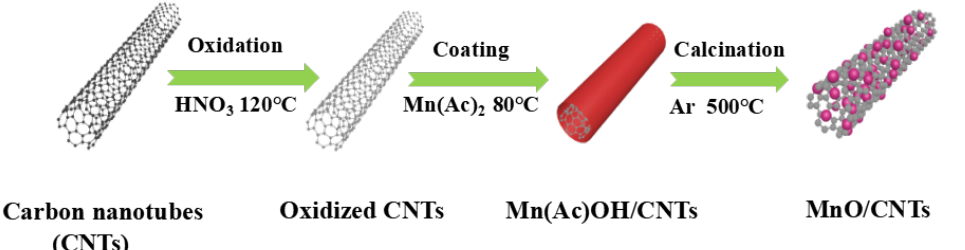
Figure 1. Schematic demonstration of the fabrication of MnO/CNTs composites.